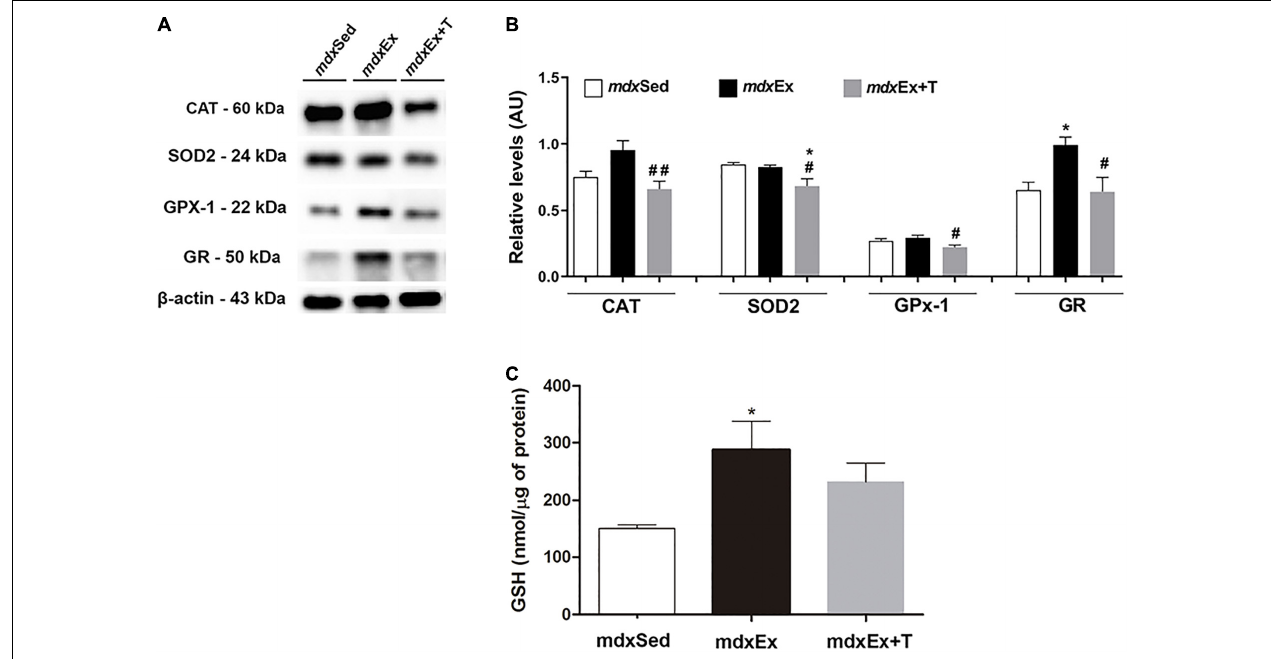
FIGURE 6 | Tempol effects on the antioxidant system levels. (A) Western blotting analysis of catalase (CAT), manganese-superoxide dismutase (SOD2), glutathione peroxidase (GPx1), and glutathione reductase (GR) content in the diaphragm (DIA) muscle from the sedentary mdx mice (mdx Sed), exercise trained mdx mice ( mdx Ex), and exercise trained mdx mice treated with Tempol ( mdx Ex+T). The blots of the proteins (top row) and β -actin (loading control, bottom row) are shown. (B) The graphs show the protein levels in the crude extracts of DIA from the mdx Sed, mdx Ex, and mdx Ex+T groups. The intensities of each band were quantified and normalized to those of the corresponding control. (C) glutathione content of the DIA muscle from the mdx Sed, mdx Ex, and mdx Ex+T groups. Relative values are expressed as mean ± standard deviation (SD). * P ≤ 0.05 compared with the mdx Sed group, # P ≤ 0.05 compared with the mdx Ex group, ## P ≤ 0.001 compared with the mdx Ex group (one-way ANOVA with Tukey’s post hoc